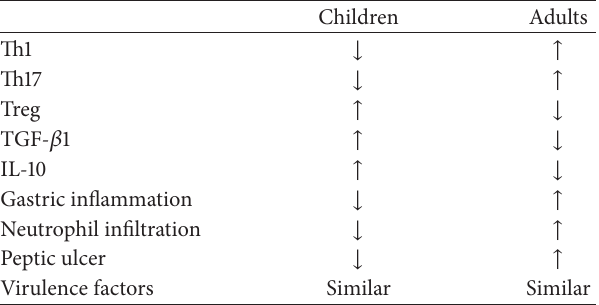
Table 1: Comparative immune response and clinical outcome in children and adults infected with H. pylori